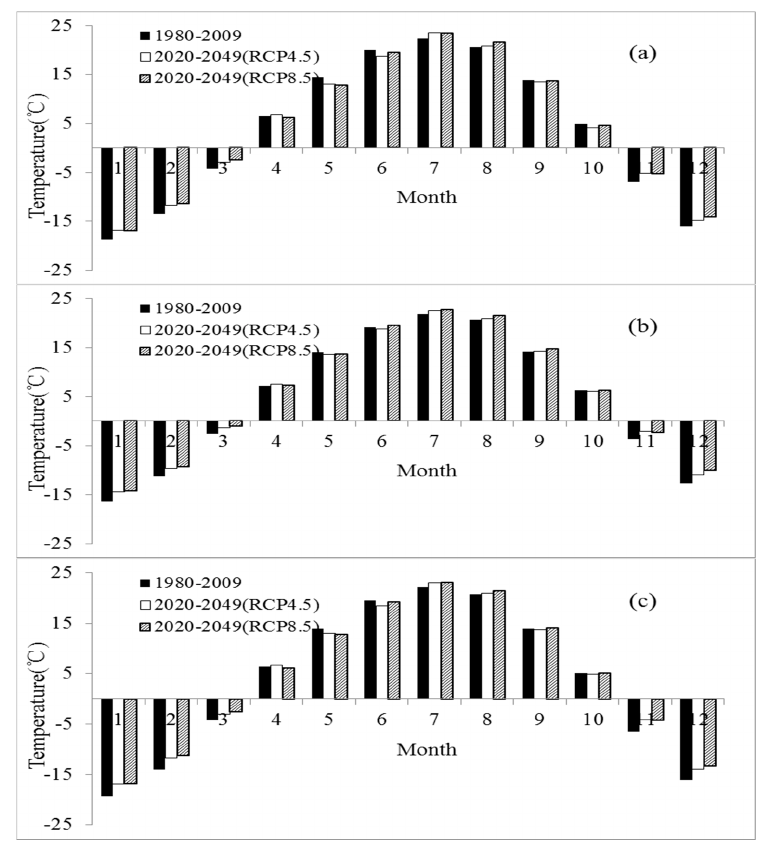
Figure 3. Changes of average monthly temperature in the Nenjiang River ( a ); Upper Songhua River ( b ); and Lower Songhua River ( c ) sub ‐ basins of the Songhua River Basin.